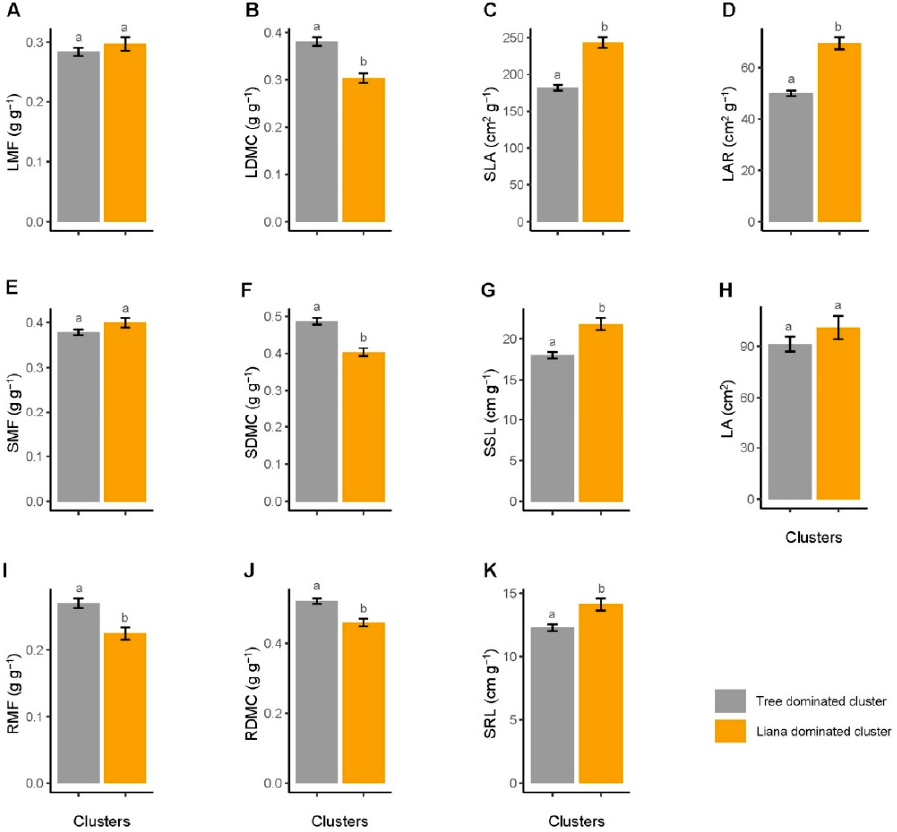
Figure 3. Trait averages of the species clusters as identified in Figure 2. Bars represent marginal means and error bars show SE (95% confidence level) for ( A ) leaf mass fraction (LMF), ( B ) leaf dry matter content (LDMC), ( C ) specific leaf area (SLA), ( D ) leaf area ratio (LAR), ( E ) stem mass fraction (SMF), ( F ) stem dry matter content (SDMC), ( G ) specific stem length(SSL), ( H ) leaf area size (LA), ( I ) root mass fraction (RMF), ( J ) root dry matter content (RDMC), and ( K ) specific root length (SRL). Letters at the top of bars indicate significant ( p < 0.05) differences among different clusters based on Tukey’s HSD test.